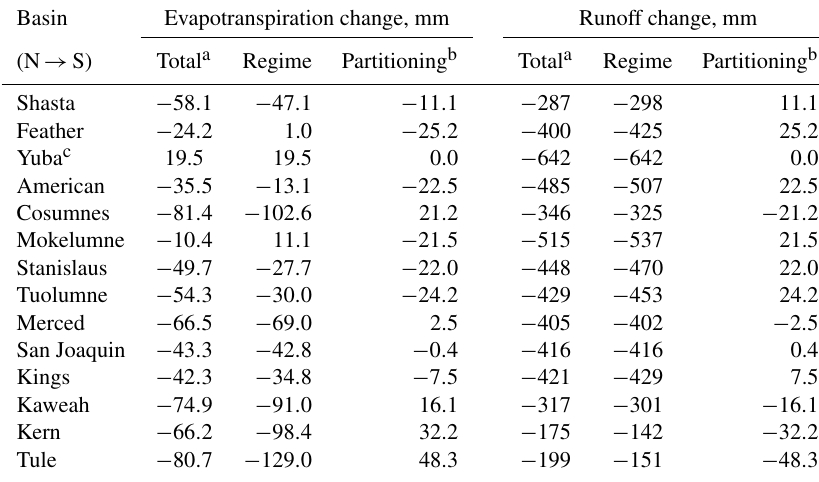
a Totals for each variable are the sum of regime and partitioning values. b Partitioning values for evapotranspiration and runoff are the negatives of each other. c Since the ω values in Yuba are both effectively infinite, the partitioning shift has no